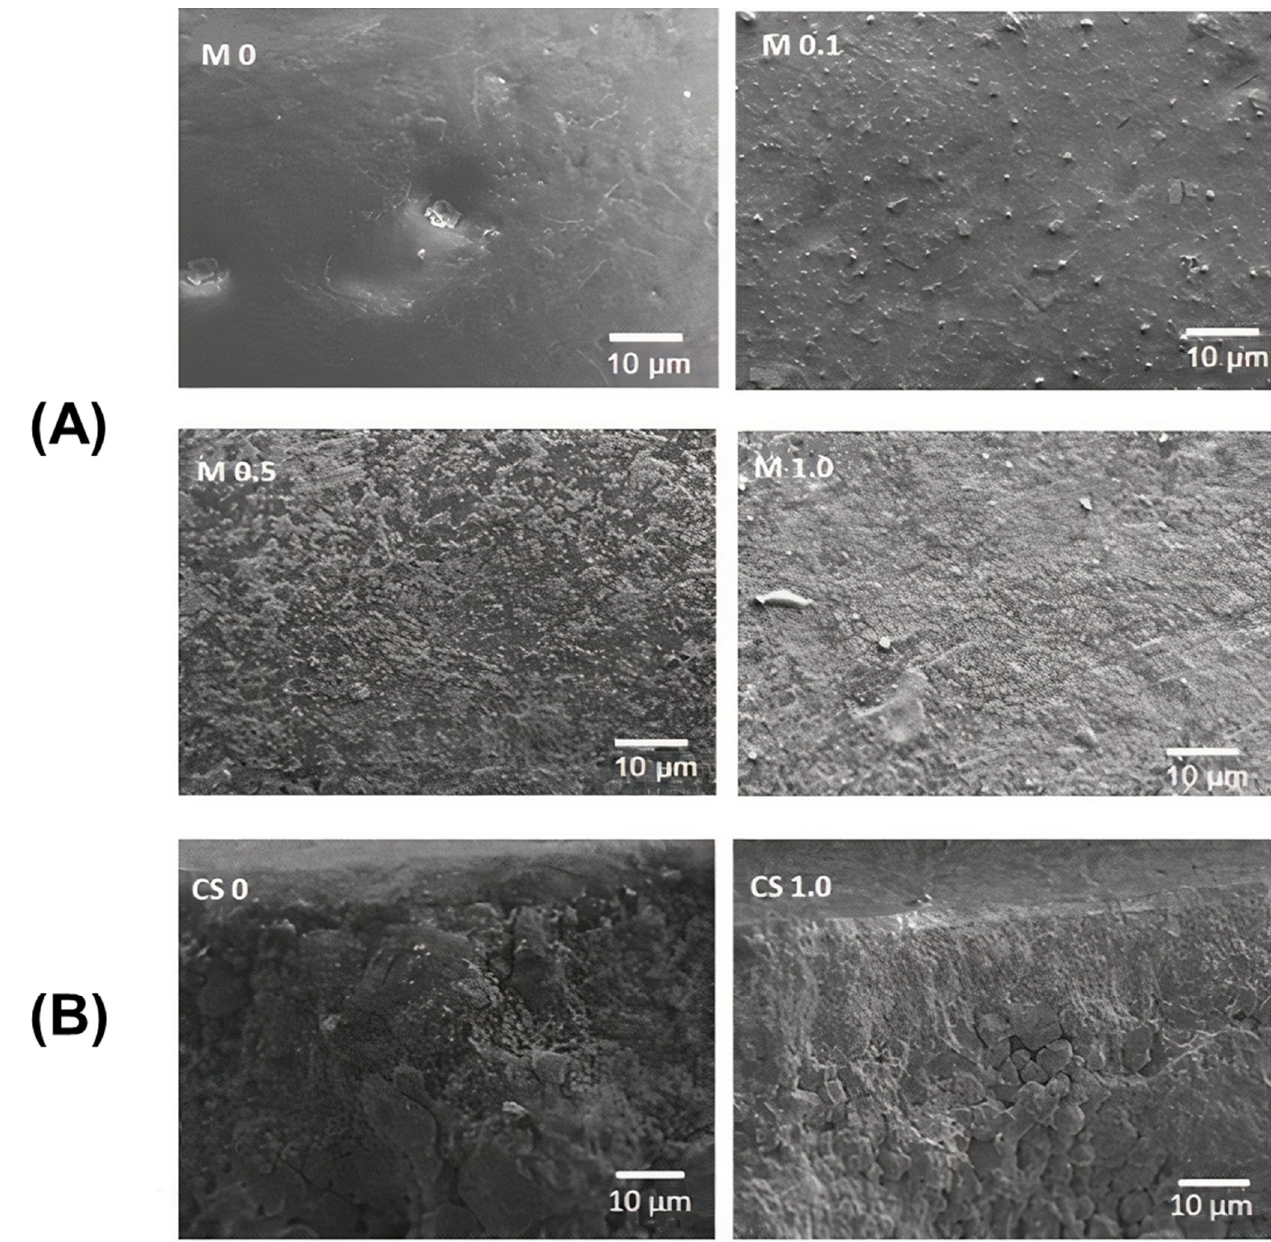
Figure 4. SEM images of ( A ) top surface and ( B ) cross-section of the membranes .